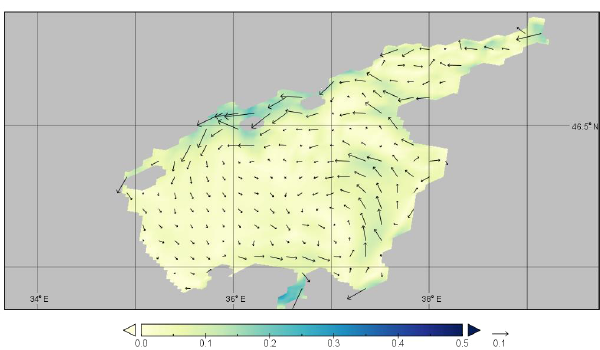
Figure 3. Daily snapshot of the surface velocity field on 15 Jan- uary 1994. It illustrates the cyclonic Rim Current, the quasi- permanent anticyclonic currents (Batumi, Sochi, and Sevastopol), and the westward outflow from the Kerch Strait spreading along the Crimean Peninsula.